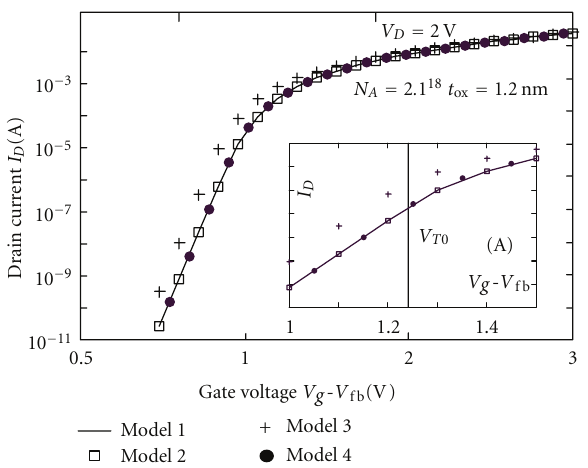
Figure 8: The correction factor F x /F 0 . (A) ( F S ( u S ( y )) + F x (0)) / 2 F 0 , +2 V th ) /t ox , and (C) Ua ( Vg +2 V th) /t ox . ( F 0 = 0 . 67 · (B) Ua ( Vg ste ff e ff 10 6 V · cm − 1 .)